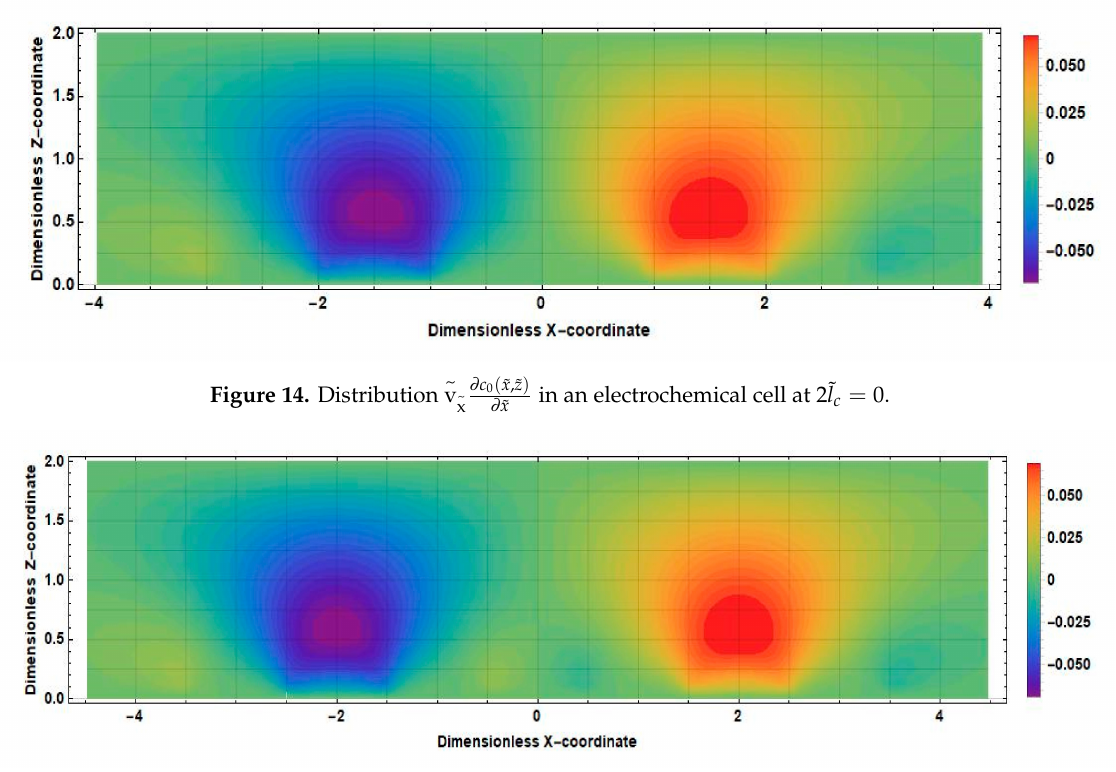
∂ c ~ 0 ( ˜ x ,˜ z ) v ~ ∂ ˜ x in an electrochemical cell at x